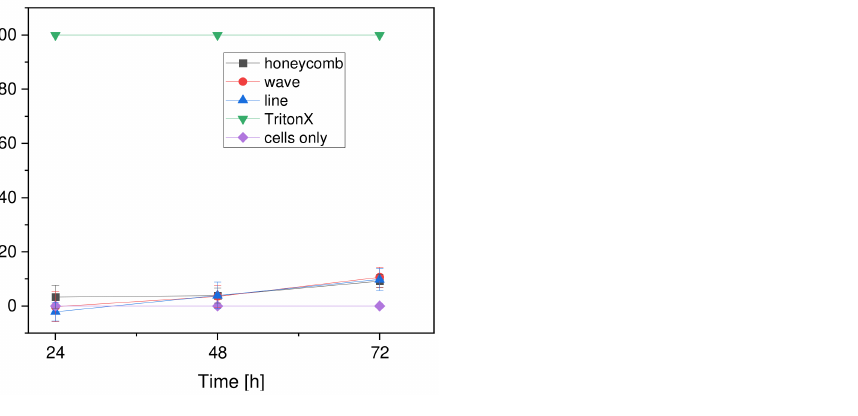
Figure 14. Overview of the cytotoxicity of the different geometries compared to negative (cells only) and positive (TritonX, all cells dead)